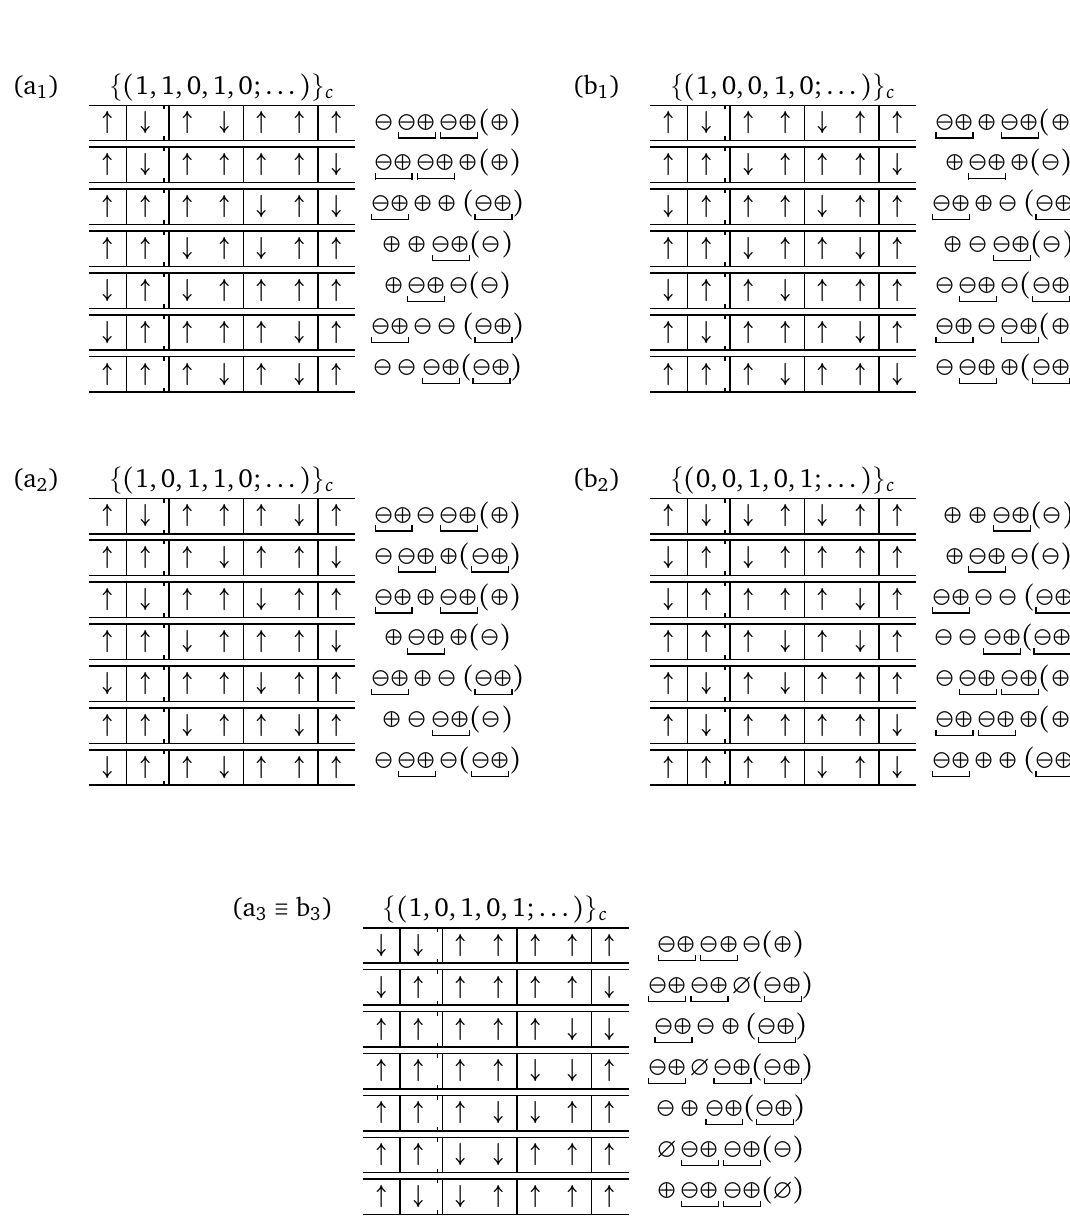
Figure 2: The same as in Fig. 1 for an odd chain with L = 7 sites; we report all the configurations analogous to those in Fig. 1 (there are more options because the sequences in Fig. 1 are defined up to cyclic permutations). The particle in parentheses is transmuted due to the periodic boundary conditions (dashed vertical line). Note that in odd chains each configuration represents a space that is invariant under a shift by one site. We point out that the states in (a 1 ), (a 2 ), ( b 1 ) and ( b 2 ) are jammed (indeed the particles can not move), so each one separately generates an invariant